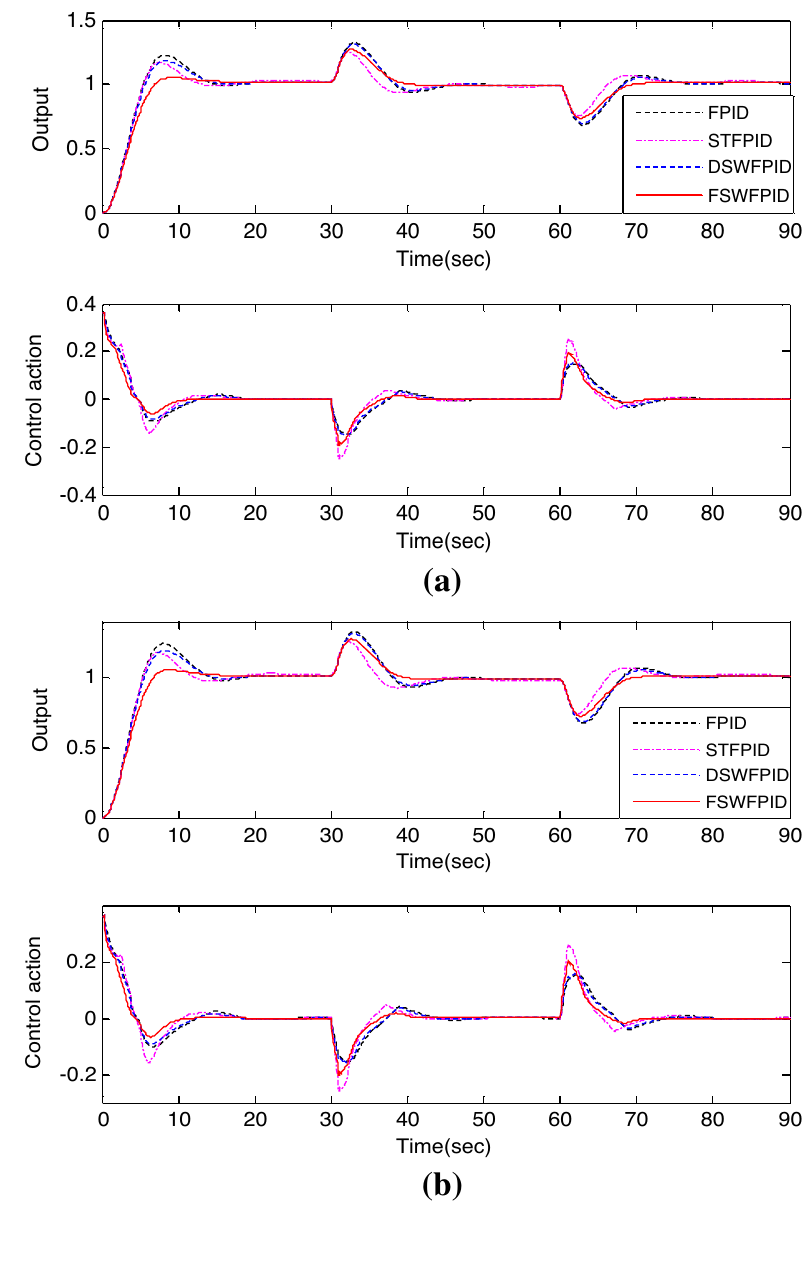
Fig. 20 Responses and control actions for Model V using 49 rules during set point response and with load variation for a L = 0.2 s, b L = 0.3